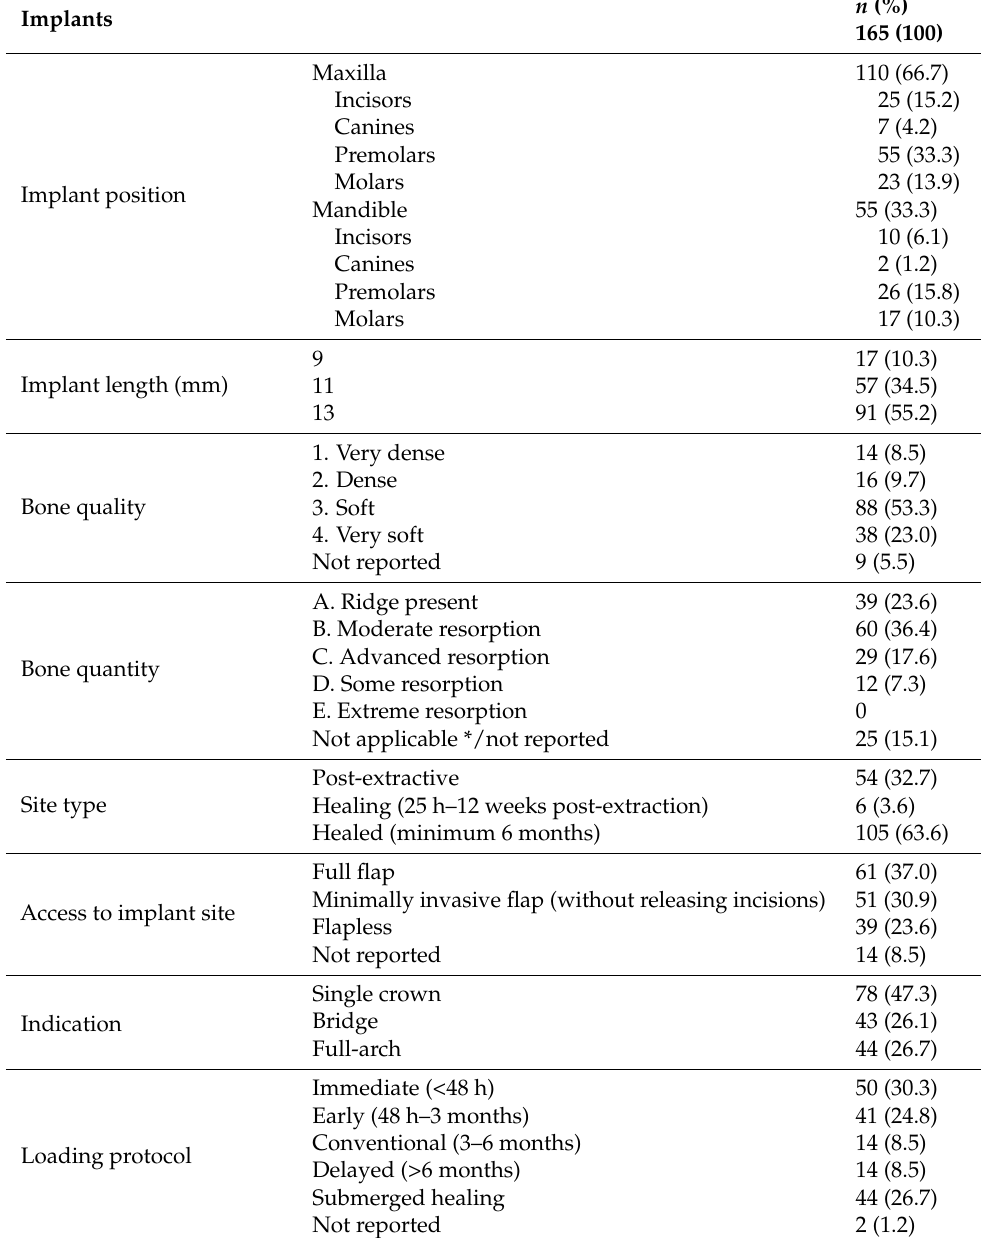
Table 1. Baseline characteristics at